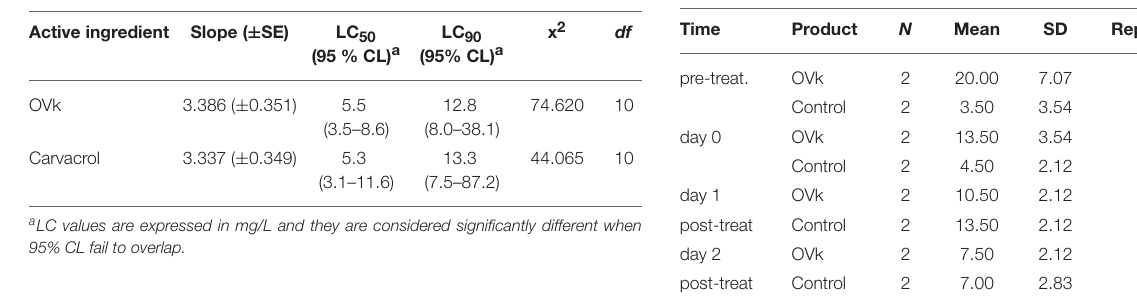
TABLE 7 | Number of Aedes albopictus females collected with HLC during the field